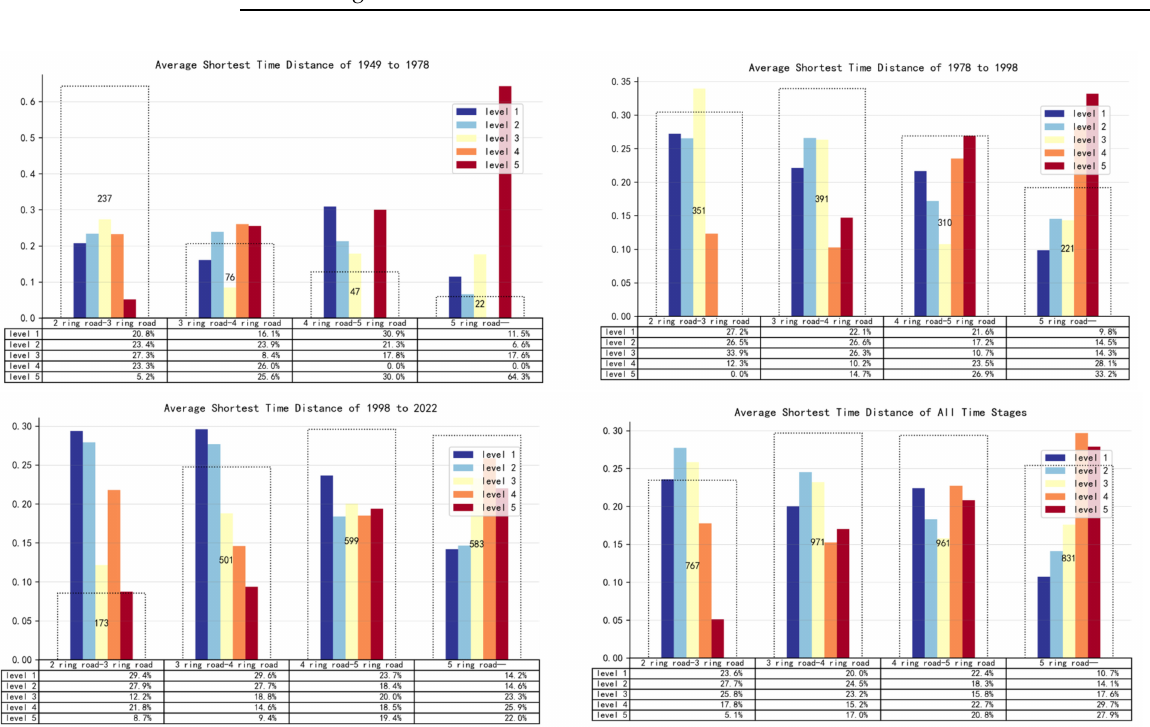
Figure 9. Measurement results of the Shortest Time Distance